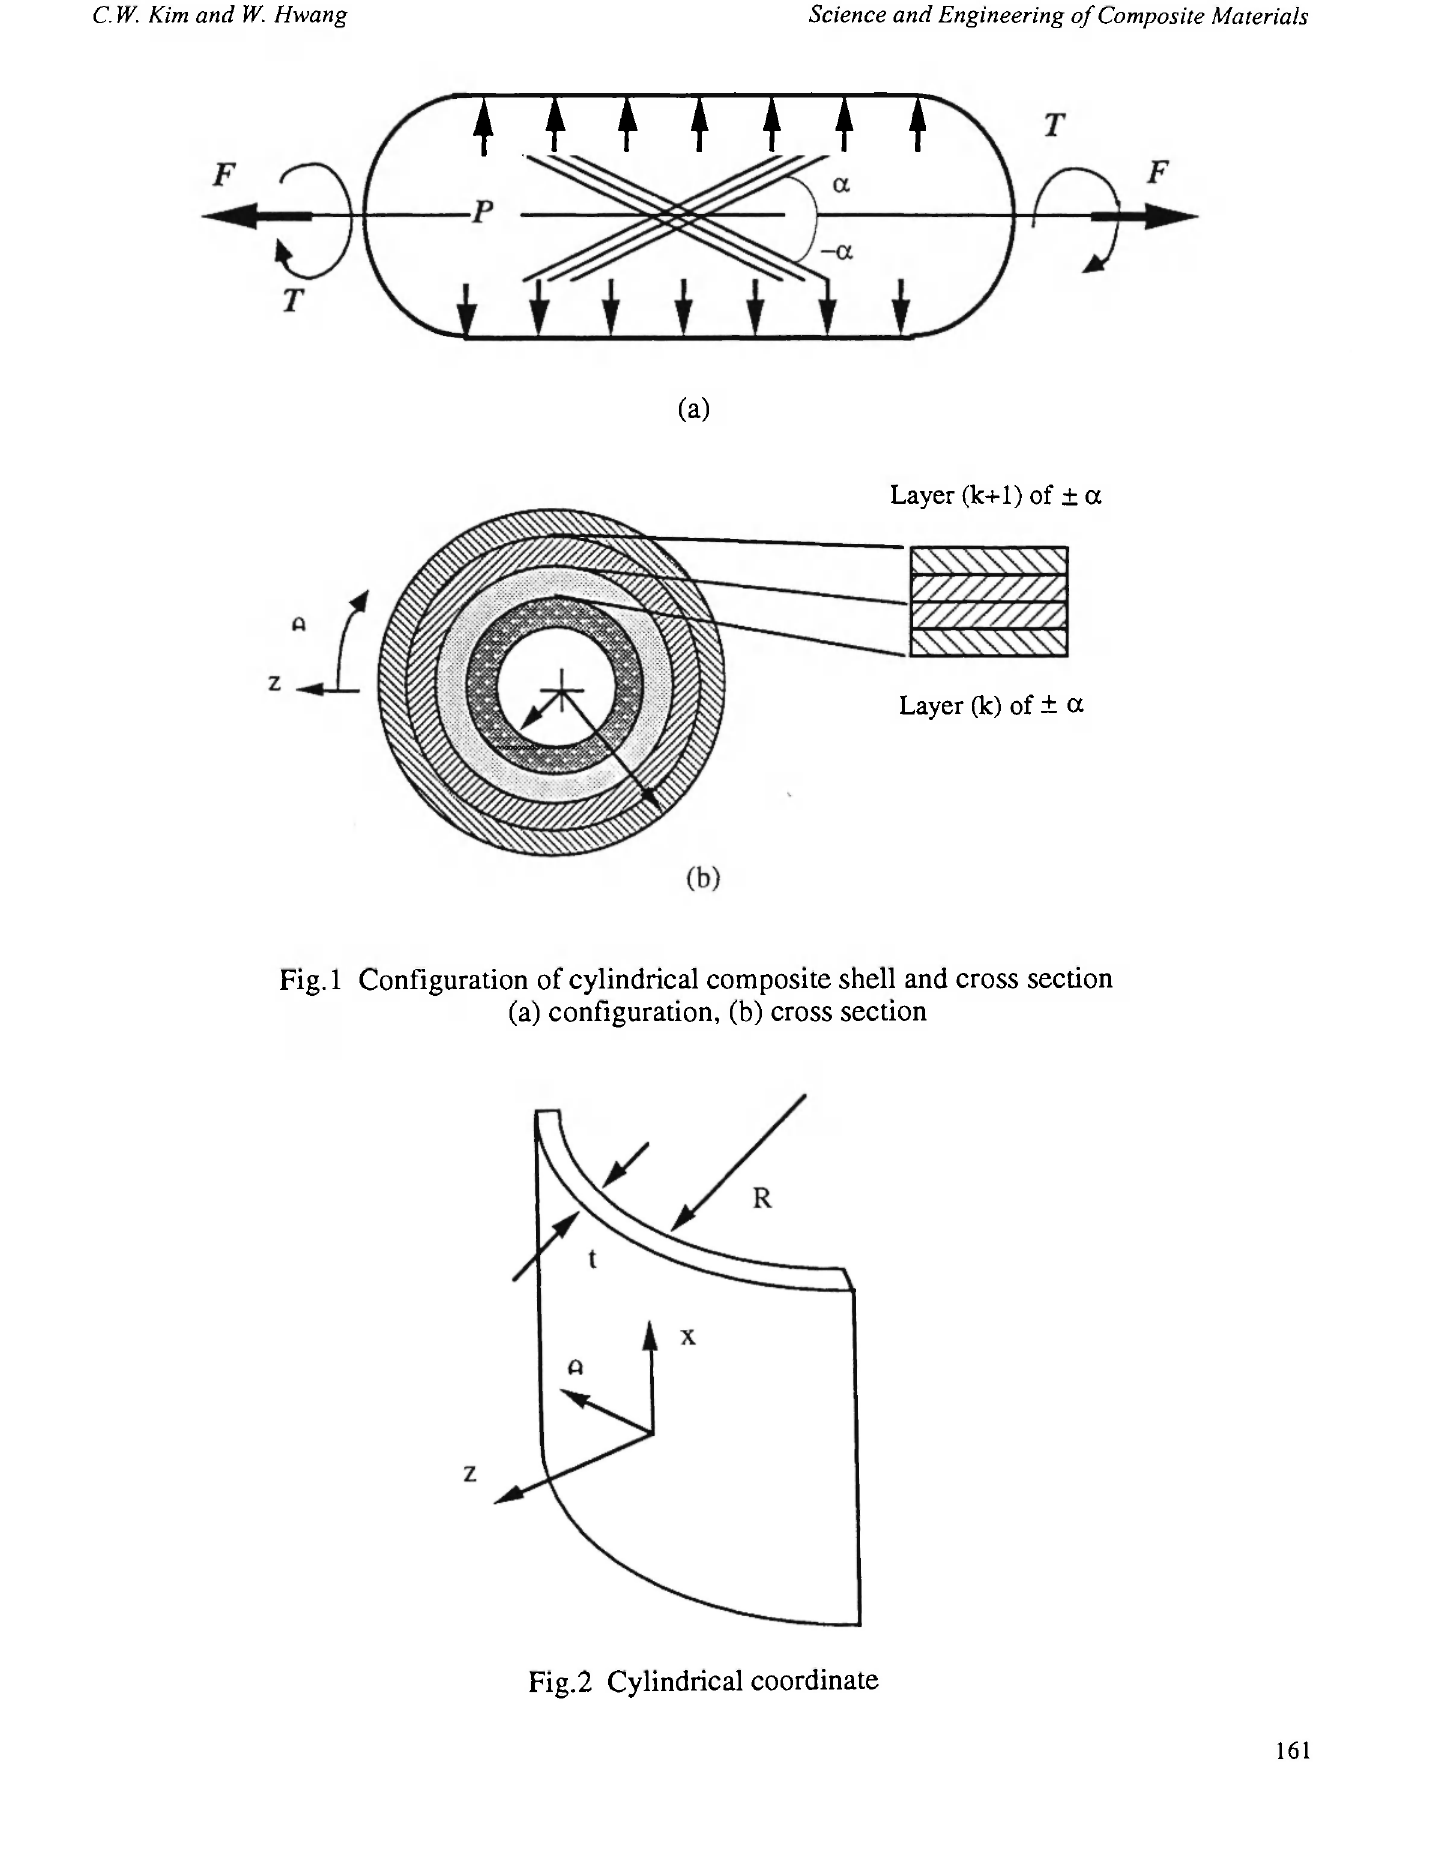
Fig.2 Cylindrical